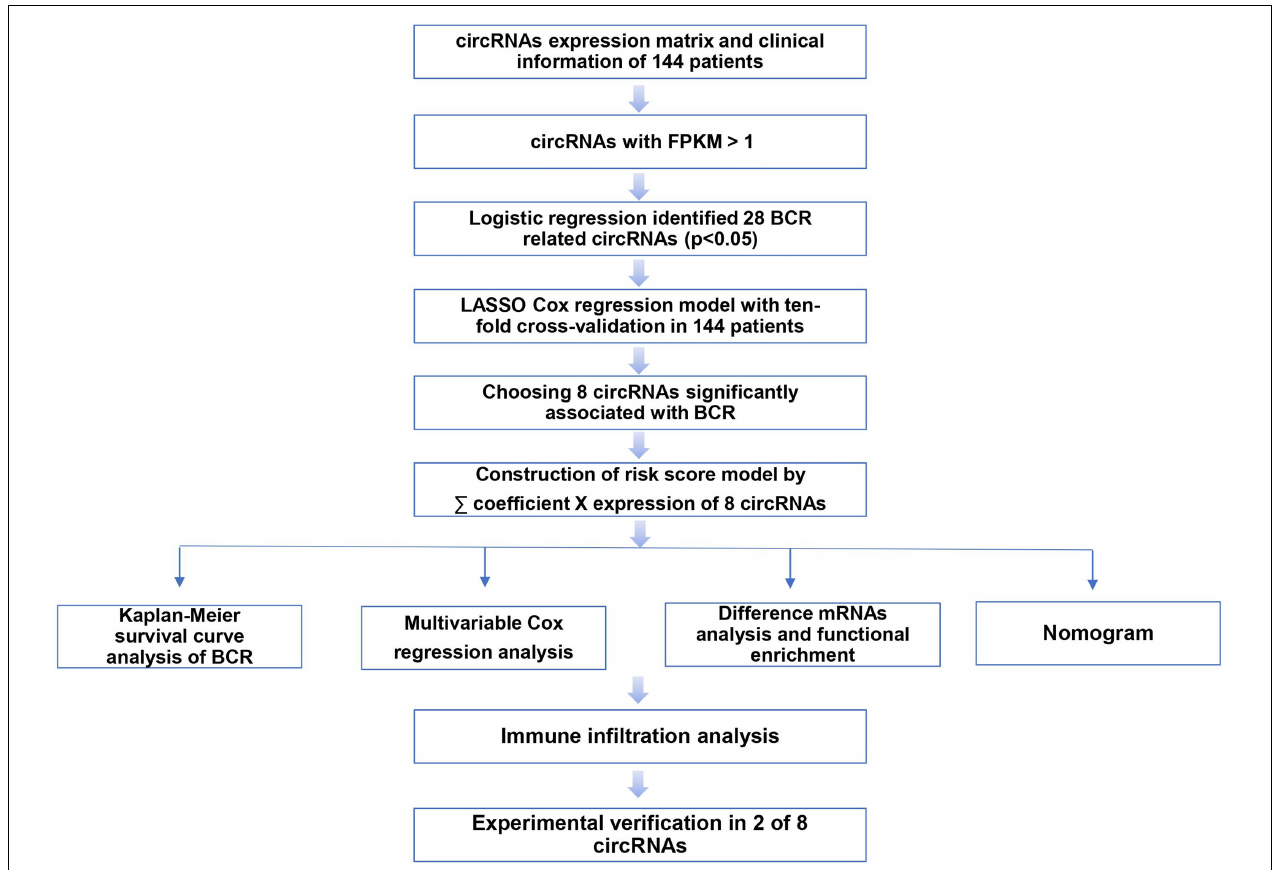
FIGURE 1 | The flow diagram of this